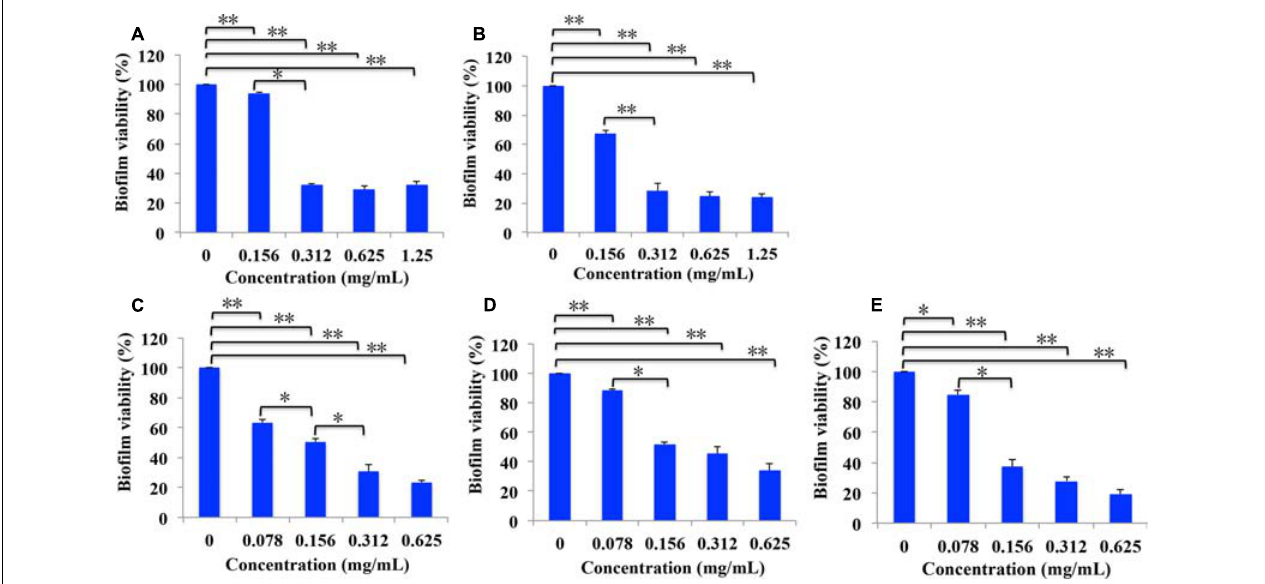
FIGURE 2 | Percentage of bacterial viability within biofilms measured by the XTT assay. (A) Extracts of 95% ethanol, (B) extracts of water, (C) sub-extracts of EtOAc, (D) sub-extracts of CHCl 3 , (E) sub-extracts of BuOH. Data are presented as the mean + standard deviation based on three individual tests. ∗ P < 0.05 and ∗∗ P < 0.01.